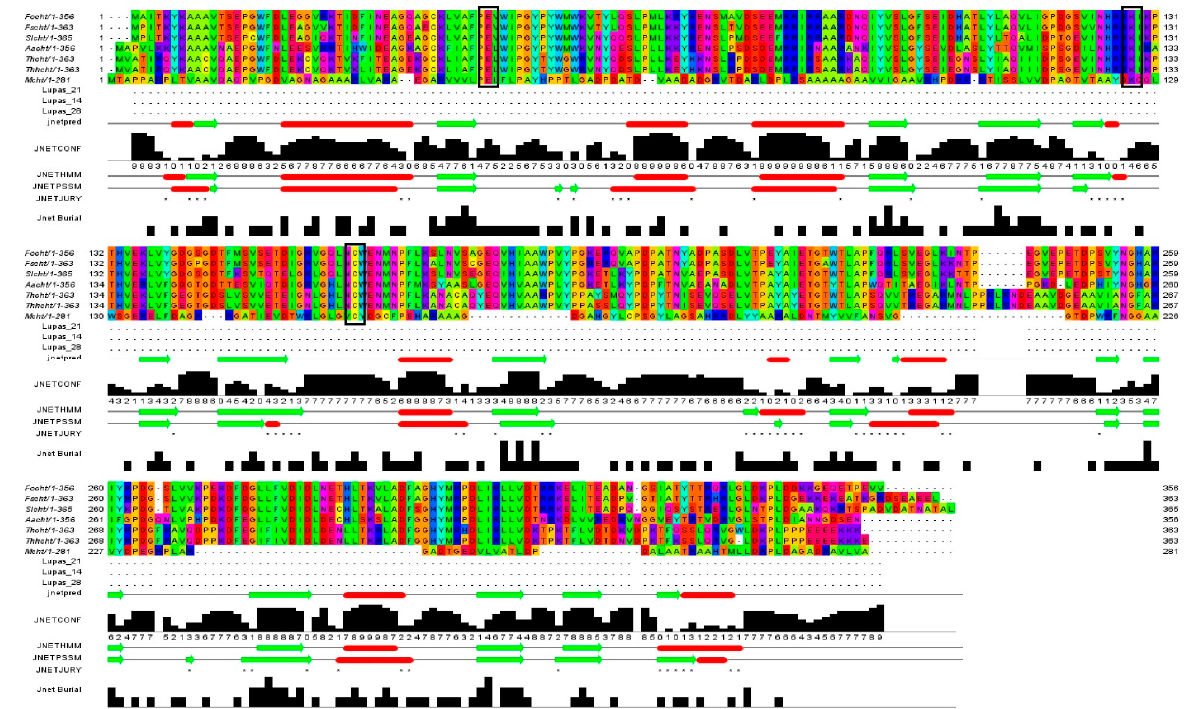
Figure 2. Conserved residues and the catalytic triad (black boxes) of cyanide hydratase isolated from fungal species. Analyzing for Verify3D score [19], 63.4 percent of amino acids produced a score of above 0.2 and 14 amino acids had a negative score, indicating a good sequence-to-structure agreement. In addition, Ramachandran plot analysis by PROCHECK server [20] showed that 98.9 percent of residues were within the most favored and allowed regions, while 1.1 percent were within the disallowed region (Figure 3A). This reconfirms that backbone dihedral angels occupied appropriate position in the predicted model. Finally, the energy of the structure was evaluated using the ProSA web server [21]. This analysis showed that the z-score of the model is within the range of scores typically found for native proteins of similar size (Figure 3B). ERRAT is a so-called “overall quality factor” and this quality score that takes non-bonded atomic interactions into consideration was 76.610, which is greater than 50, set as a threshold for high-quality structures [22] (Figure 3C).